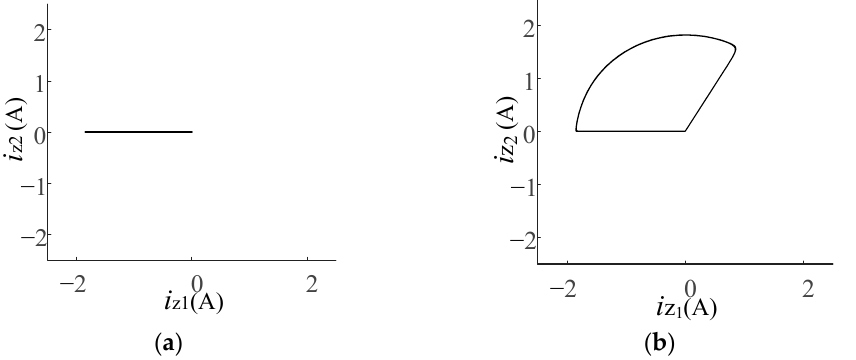
Figure 4. z 1 -z 2 plane current in case of different power switch faults; ( a ) z 1 -z 2 plane current waveform Figure 4. z 1 - z 2 plane current in case of different power switch faults; ( a ) z 1 - z 2 plane current waveform in case of T1 fault; ( b ) z 1 -z 2 plane current waveform in case of T1 and T2 faults. in case of T1 fault; ( b ) z 1 - z 2 plane current waveform in case of T1 and T2 faults. The reference direction of the current vector during each phase fault can be expressed as: